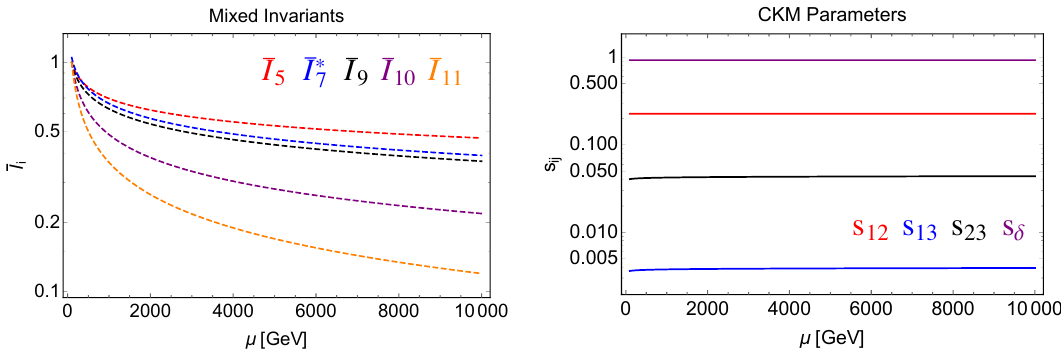
Figure 2 . Left : running of the (normalized) mixed invariants relevant for extracting the CKM mixing elements, at one-loop order. Note that ¯ I 7 has been multiplied by 1.05 in order to visually distinguish it from ¯ I 5 . Right : running of the mixing angles and Dirac CP-violating phase of the CKM matrix, again at one-loop